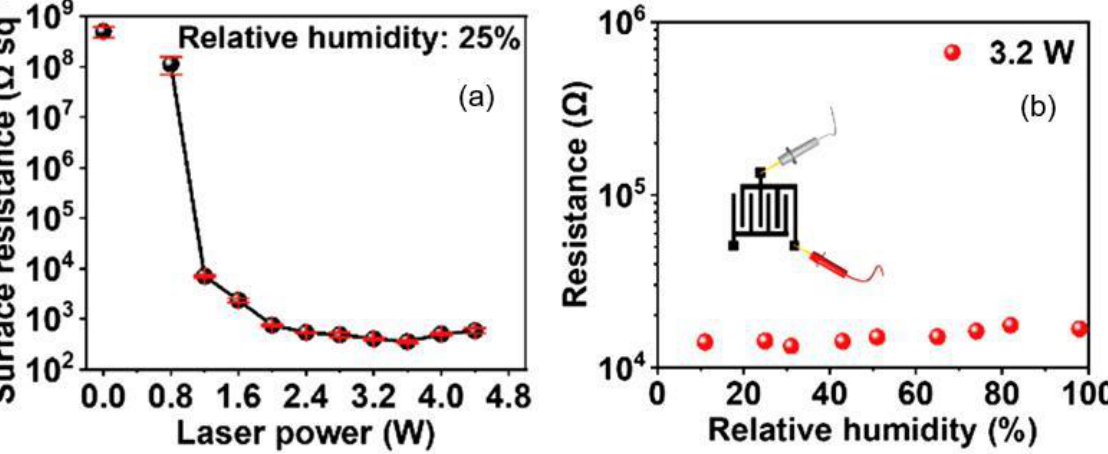
Figure 20. CO 2 -laser-induced direct formation of electrodes on TEMPO-oxidized cellulose paper: ( a ) surface resistance as a function of laser power used for laser irradiation, ( b ) relationship between relative humidity and electrical resistance of laser-induced electrodes prepared at laser powers of 3.2 W. Laser scan speed: 10 cm s −1 . The resistance was measured at room temperature. Reprinted from [302]. Published 2022 by RSC as open access.